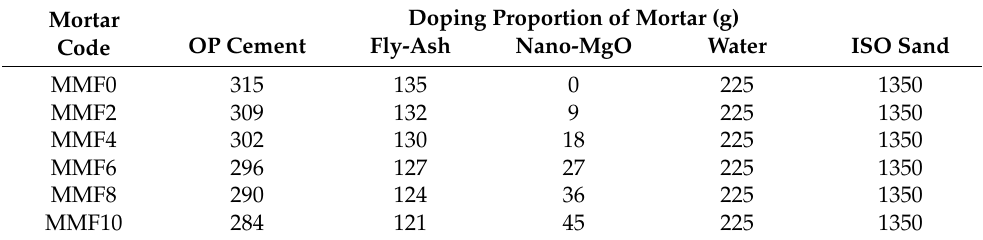
Table 3. Doping ratio of cement